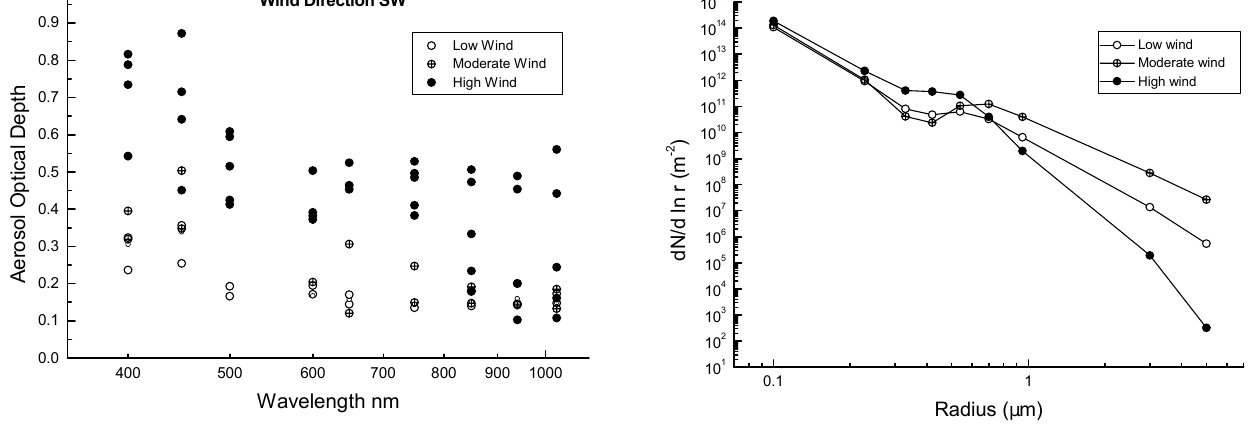
Fig. 8. Same as Fig. 7 for southwest wind condition.